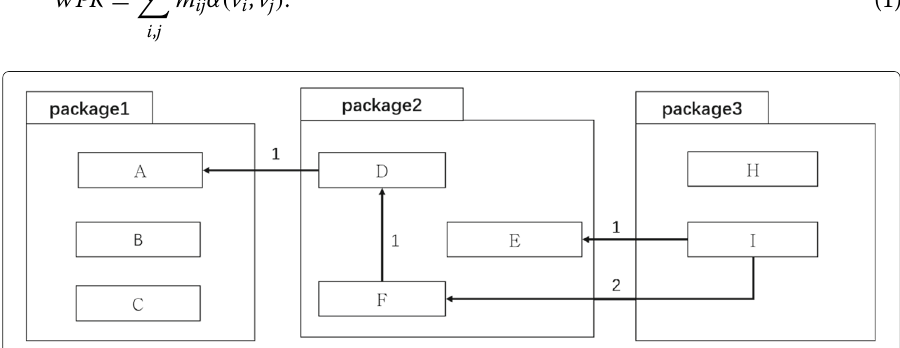
Fig. 2 An Example of